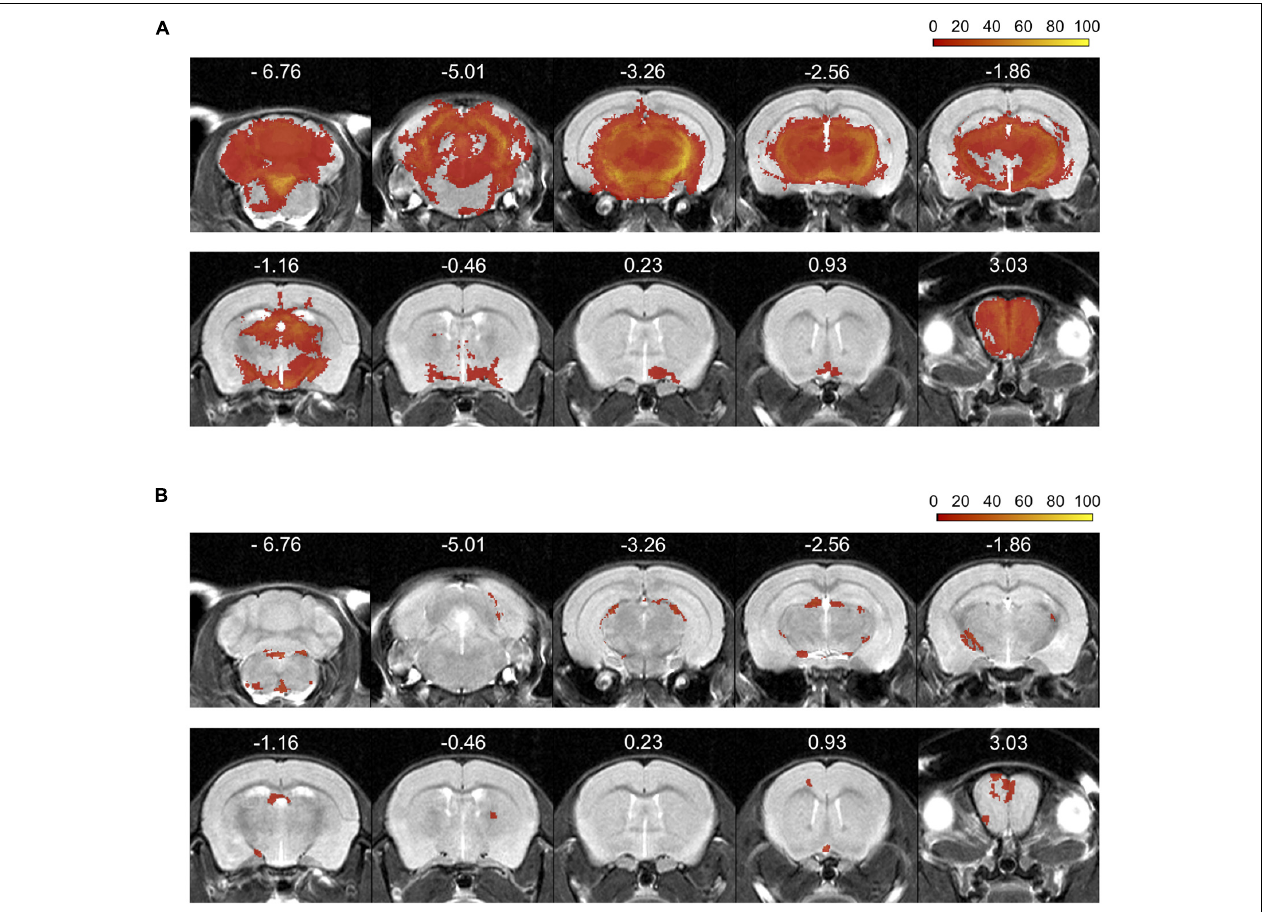
FIGURE 3 | Percentage incidence maps for Gd-enhancement and Eu-VSOP accumulation during EAE. (A) Incidence (% of mice affected) of gadolinium distribution across the brain, displaying large diffuse lesions along the cerebral cortex, cerebral nuclei, brain stem, midbrain and fiber tracts ( n = 19). (B) Conversely, Eu-VSOP distribution appears to be characterized by smaller and focal areas of accumulation in the cerebral cortex, cerebral nuclei, brain stem, midbrain and fiber tracts ( n = 11).